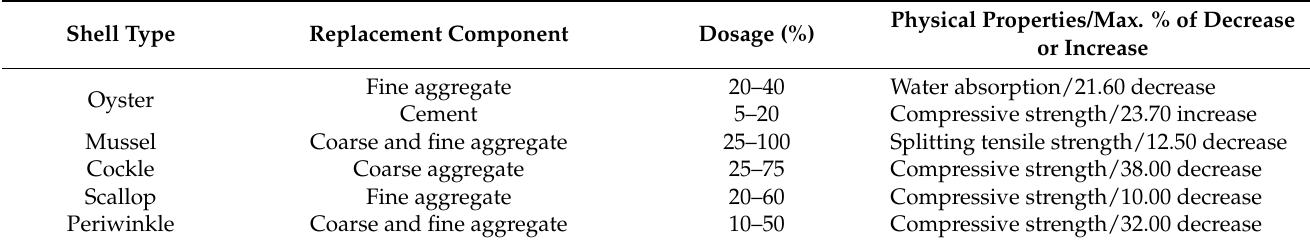
Table 3. The effects on the product performance when using various types of shells as cement additives or concrete aggregates. The presence of waste shells generally reduces the strength of concrete (particularly as the replacement dosage increases) but it remains within the acceptable range. Adapted from Zhan et al.